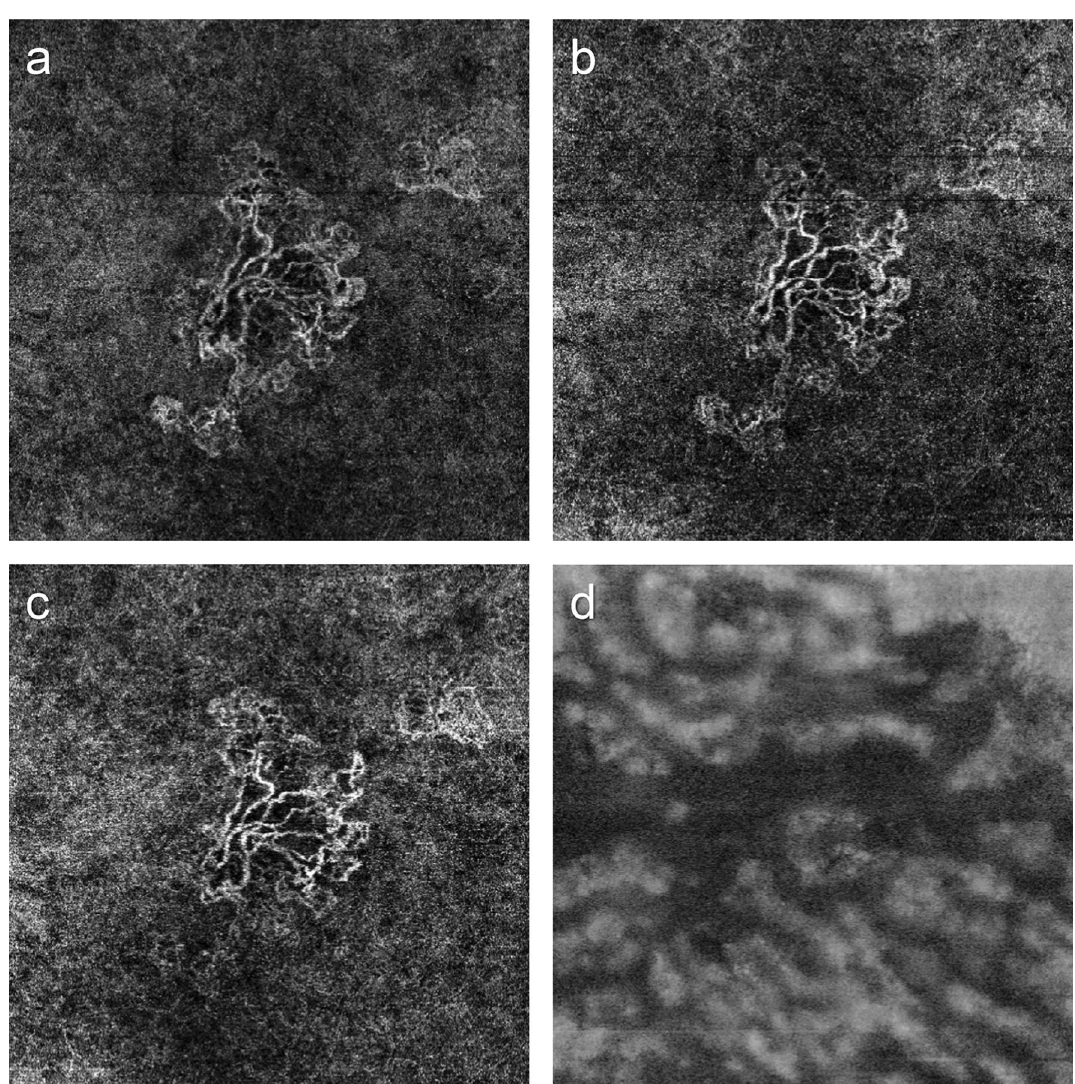
Figure 1. Changes in macular neovascularization (MNV) and Haller vessel morphology in eyes with no visual acuity gain and frequent injections. ( a ) Initial optical coherence tomography angiography image of a patient before the first injection shows MNV. At the initial visit, the best-corrected visual acuity was 20/40, which changed to 20/50 after 1 year. The total number of injections administered was 6. Central branches with peripheral anastomotic changes were present. The vessel area was 2.0 mm 2 , while the mean and maximal vessel diameters were 21.5 and 78.6 μm, respectively. ( b ) The central vessels were dilated after three loading injections, while peripheral anastomoses were not markedly shrunken. The vessel area was 2.2 mm 2 , while the mean and maximal vessel diameters were 20.7 and 65.5 μm, respectively. ( c ) After 1 year, the inferior part of the MNV had decreased, but the central vessel and peripheral anastomotic lesions retained their initial morphologies. The vessel area was 2.5 mm 2 , and the mean and maximal vessel diameters were 20.4 and 65.0 μm, respectively. ( d ) En face Haller vessel imaging after three loading doses showed dilation (the mean and maximum diameters were 144.3 and 851.5 μm, respectively) with a relatively shorter total length (41.1 Haller vessel and MNV parameters associated with visual gain. Univariate logistic regression for each morphological factor adjusted by age, sex, and baseline visual acuity revealed that visual gain group was associated with a smaller maximal MNV diameter after three loading doses and a longer mean MNV branch length at 12 months. Additionally, the visual gain group was associated with a larger decrease in the maxi- mal MNV diameter and the MNV area after three loading doses than at baseline (Table 2, Figs. 1, 2, Supple- mentary Figs. 1, 2). No Haller vessel-associated factors were found (Table 2). Multivariate regression analysis revealed that visual gain was associated with smaller maximal MNV diameters after three loading doses (odds ratio = 0.22, P = 0.03).